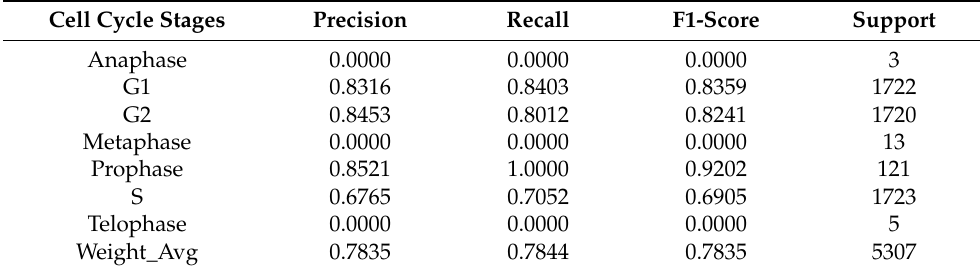
Table 5. The seven-stage classification results for the original images.